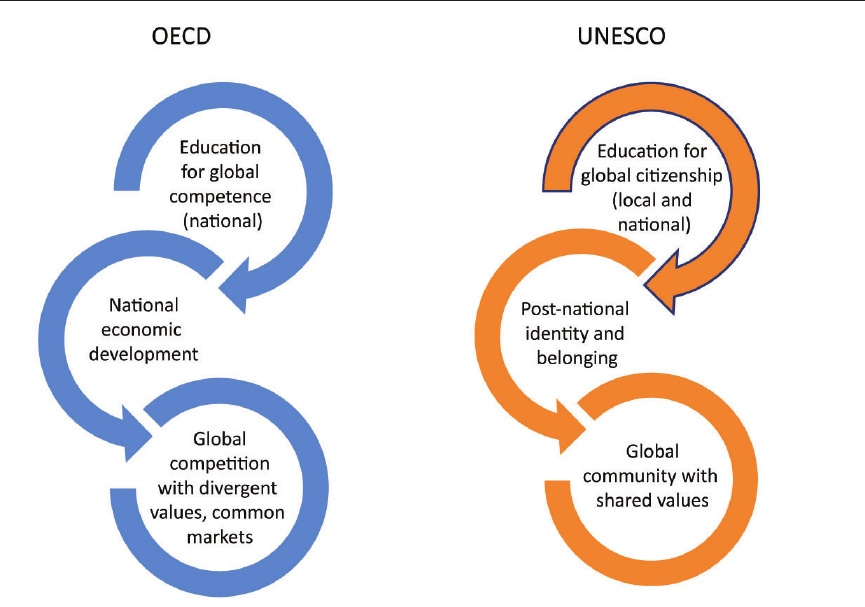
Figure 7: Pathways of policy